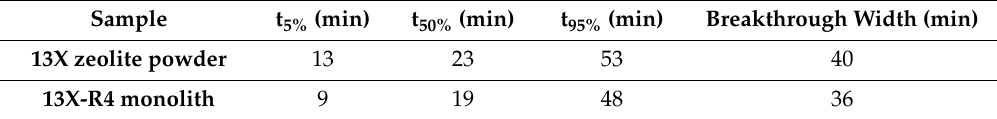
Table 2. Breakthrough times for the samples [65].